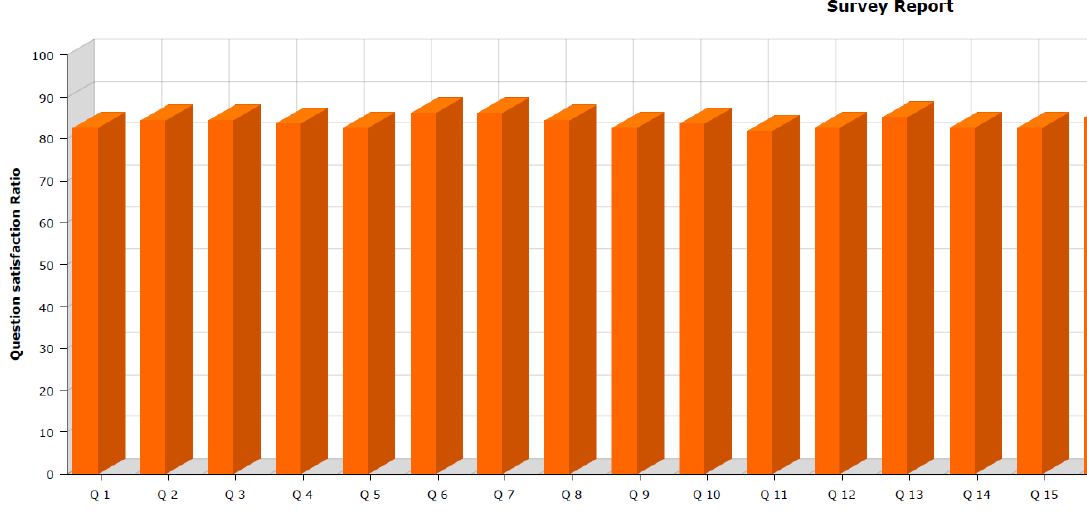
Figure 11. Course satisfaction Figure 12. Course satisfaction ratio.